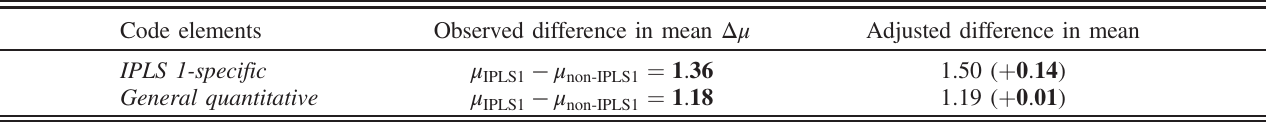
TABLE IV. Results of ANCOVA with average Natural Science and Engineering (NSE) GPA as a covariate. For IPLS 1-specific code elements, the difference in mean between IPLS 1 and non-IPLS 1 students increases when controlling for NSE GPA (first row), and for general quantitative skill elements the difference in mean between IPLS and non-IPLS students changes negligibly when controlling for NSE GPA (second row).